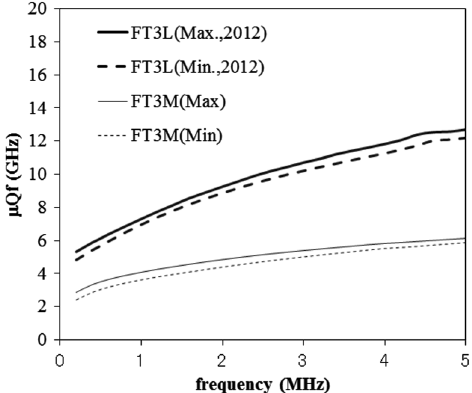
FIG. 12. Characteristics of MA cores for the J-PARC accelerator use. The FT3M cores (thin lines) are currently used for the J-PARC. The recent production (bold lines) shows 2 times higher